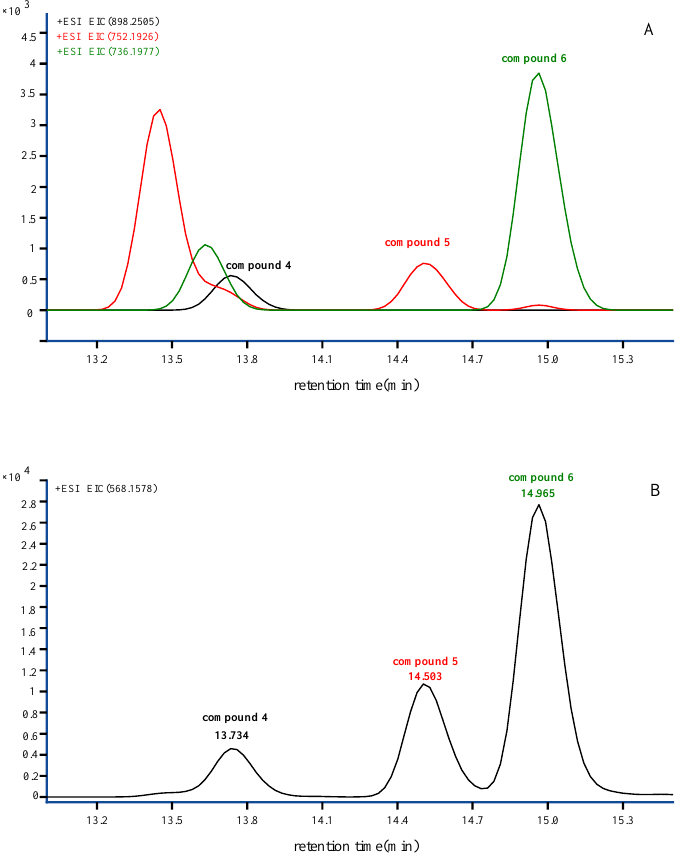
Figure 5. EICs of characteristic ions [M + Na] + ( A ) and m / z 568.1578 ( B ) found in the extract of Arabidopsis thaliana (L.) exposed to Tabun.